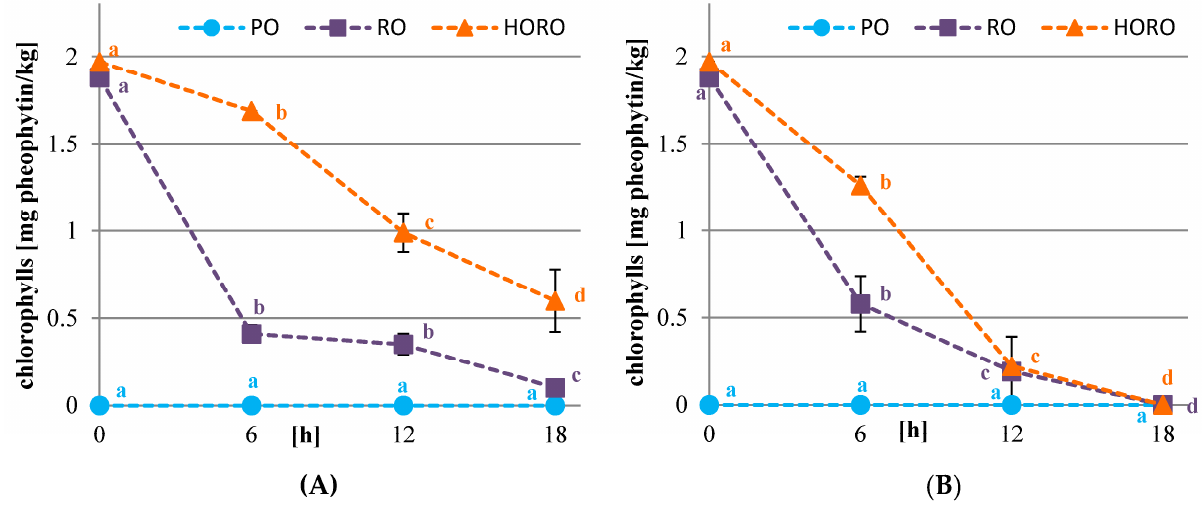
Figure 2. Changes in the content of chlorophyll pigments [mg pheophytin/kg oil] of tested oils during deep frying of potatoes ( A ) or tofu ( B ). PO—palm olein; RO—cold pressed rapeseed oil; HORO—cold pressed high oleic rapeseed oil. The values for the specific oil with different letters (a, b, c, d) are significantly different ( p < 0.05).